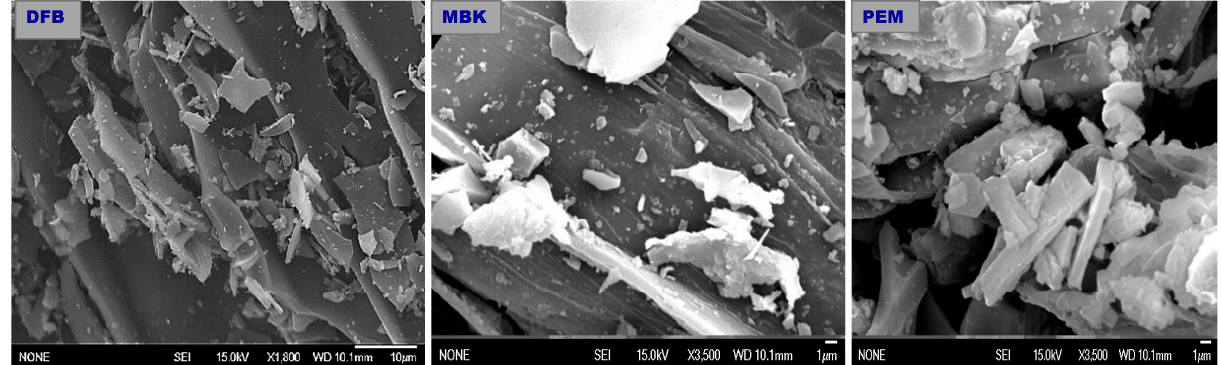
Figure 1. Scanning electron microscope (SEM) images of untreated Douglas fir biochar (DFB), DFB treated with MgCl 2 · 6H 2 O + KOH solutions (MKB), and MBK treated with KH 2 PO 4 solution (PEM).